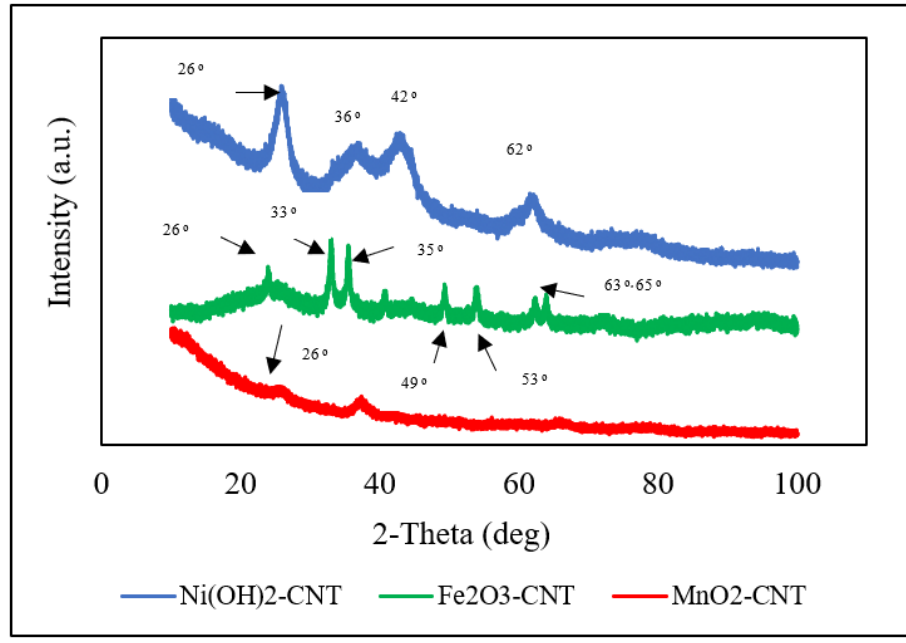
Figure 5. XRD spectra of MO-CNT hybrids.